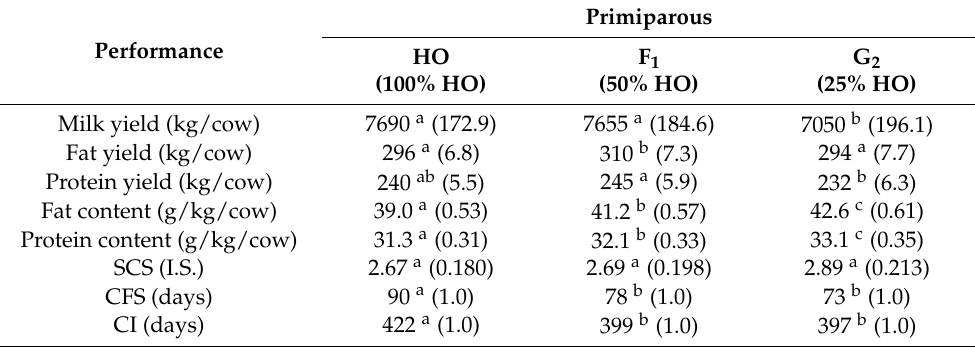
Table 5. Least square means estimates (standard error in parentheses) of 305-d milk, fat and protein yields, fat and protein contents, somatic cell score (SCS), calving to first service interval (CFS) and calving interval (CI) for primiparous cows of the three genetic classes: Holstein (HO), first-generation crossbreds with 50% of Holstein genes (F 1 ) and three-breed crossbreds of second generation with 25% of Holstein genes (G 2 ).